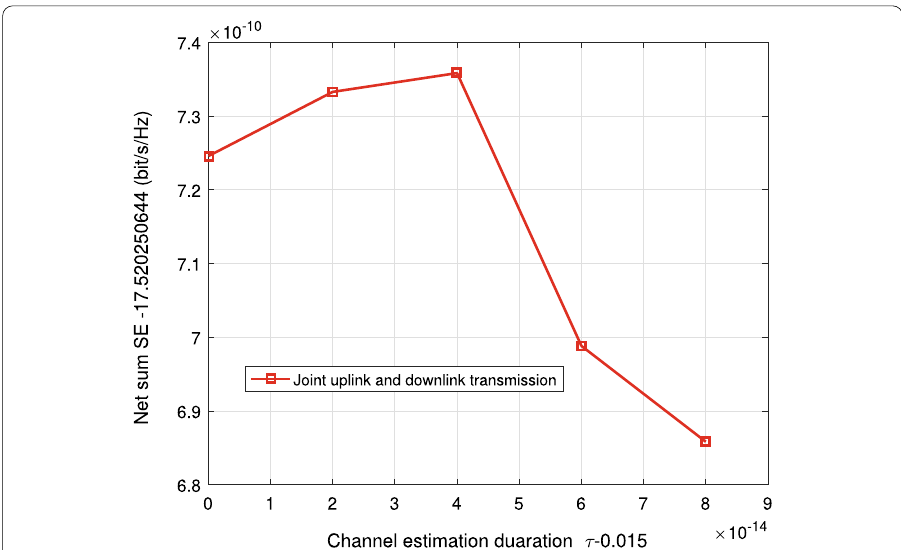
Fig. 5 Net sum spectral efficiency of uplink and downlink versus channel estimation